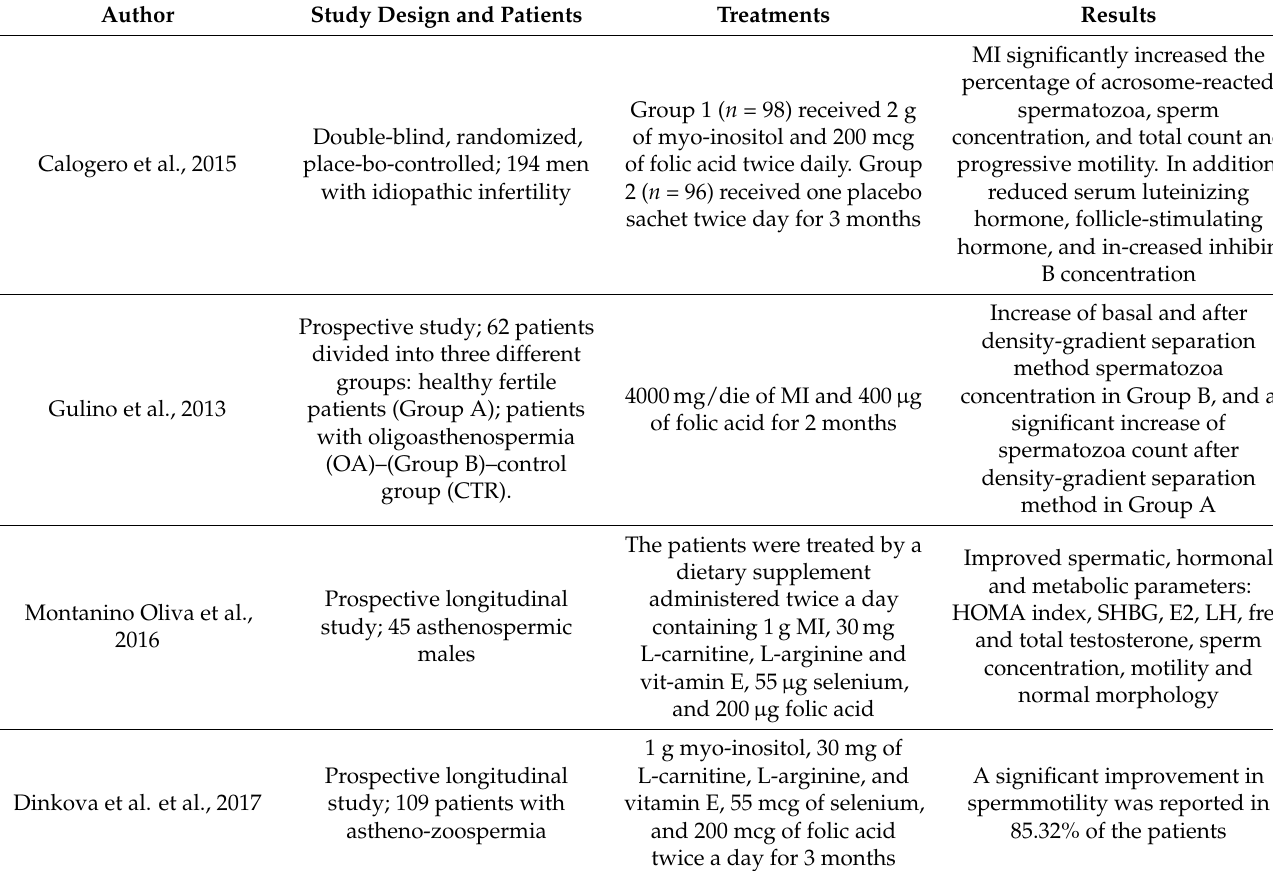
Table 2. Myo-inositol: in vivo